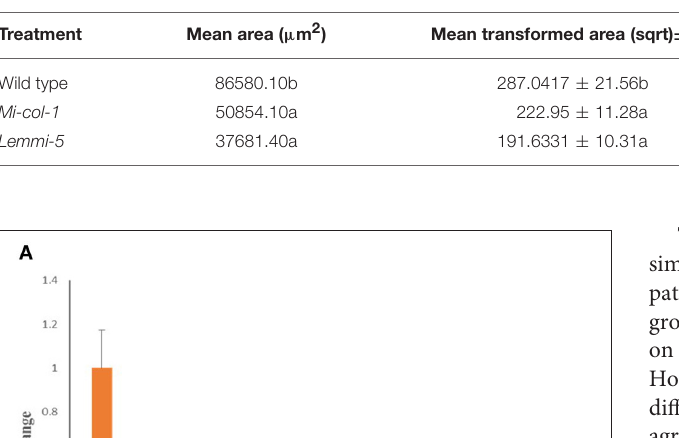
TABLE 2 | Area and diameter of Meloidogyne incognita females isolated from wild type and transgenic RNAi lines.